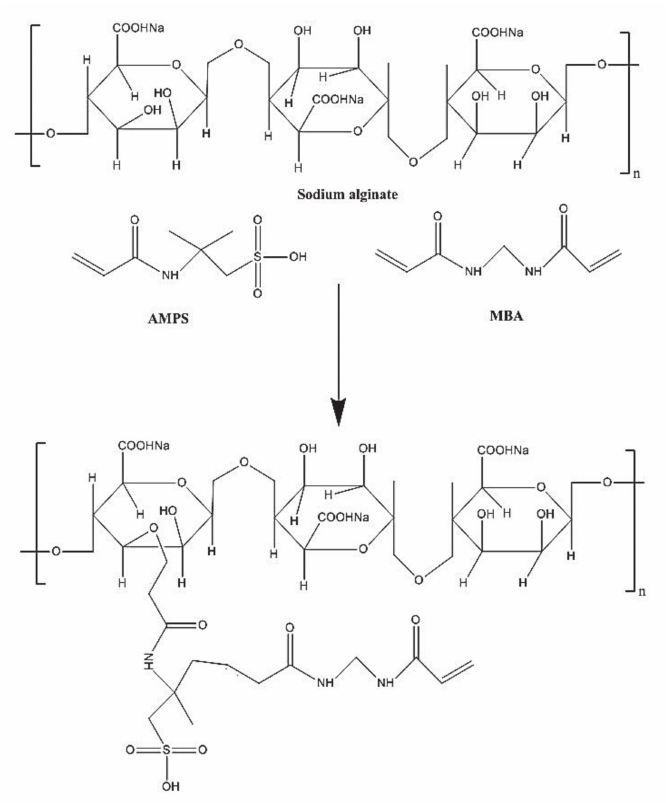
Figure 3. Possible chemical structure of SA-co-poly(AMPS)